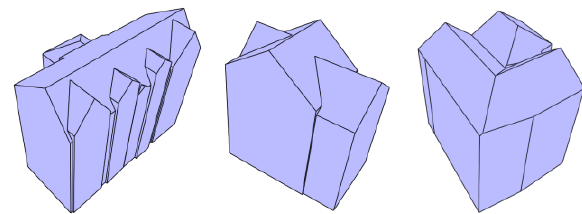
Figure 13. Three examples of automatically reconstructed 3D building models.